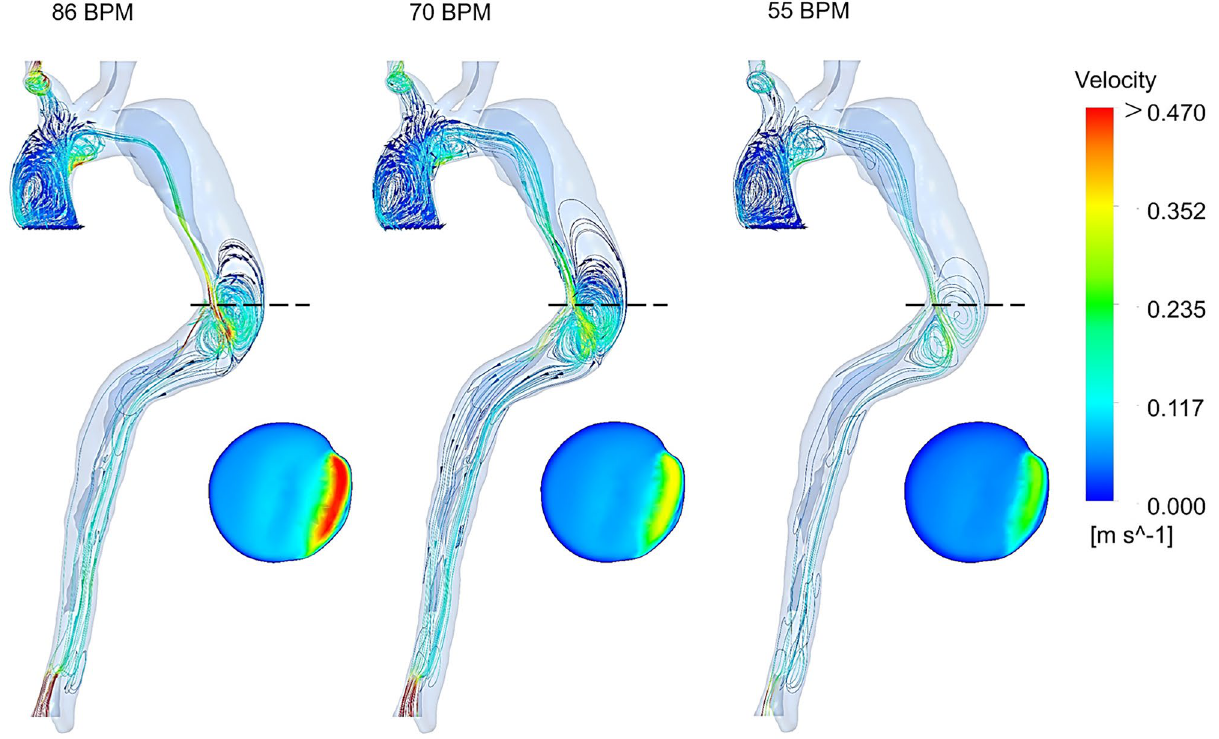
Figure 4. Streamlines and velocity contours during end-diastole (dashed lines indicate the position of selected cross-sectional planes in the middle of entry tear and the scale bar shown in the figure indicates all contours).